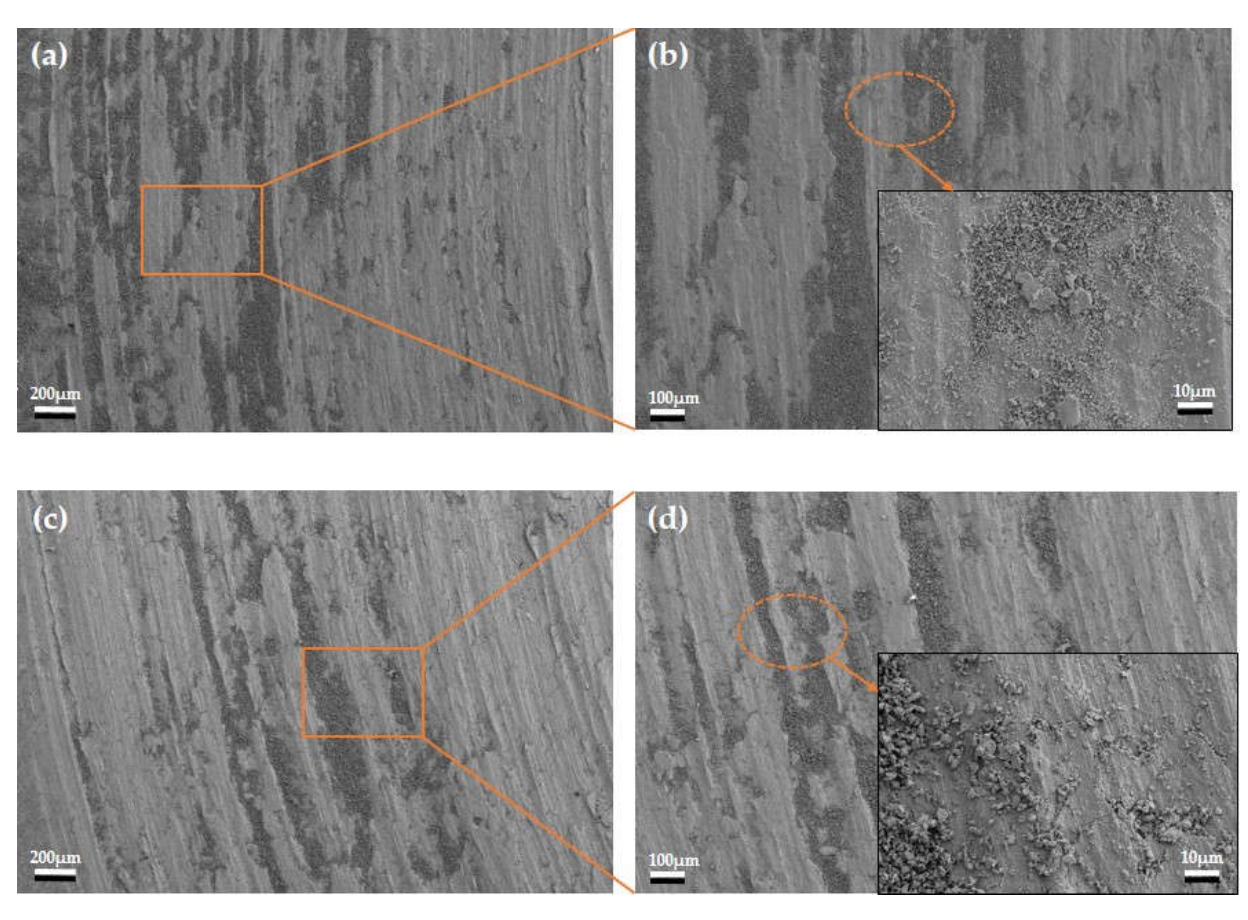
Figure 9. FESEM images of worn disc surface for (a,b) pure MoS 2 disc and (c,d) g-C 3 N 4 /MoS 2 (9 wt.%) nanocomposite coated disc.